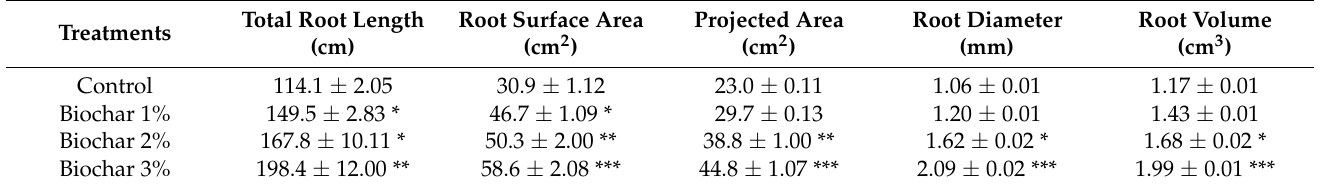
Table 3. The impact of biochar concentrations on root morphological traits of ginger. Treatments